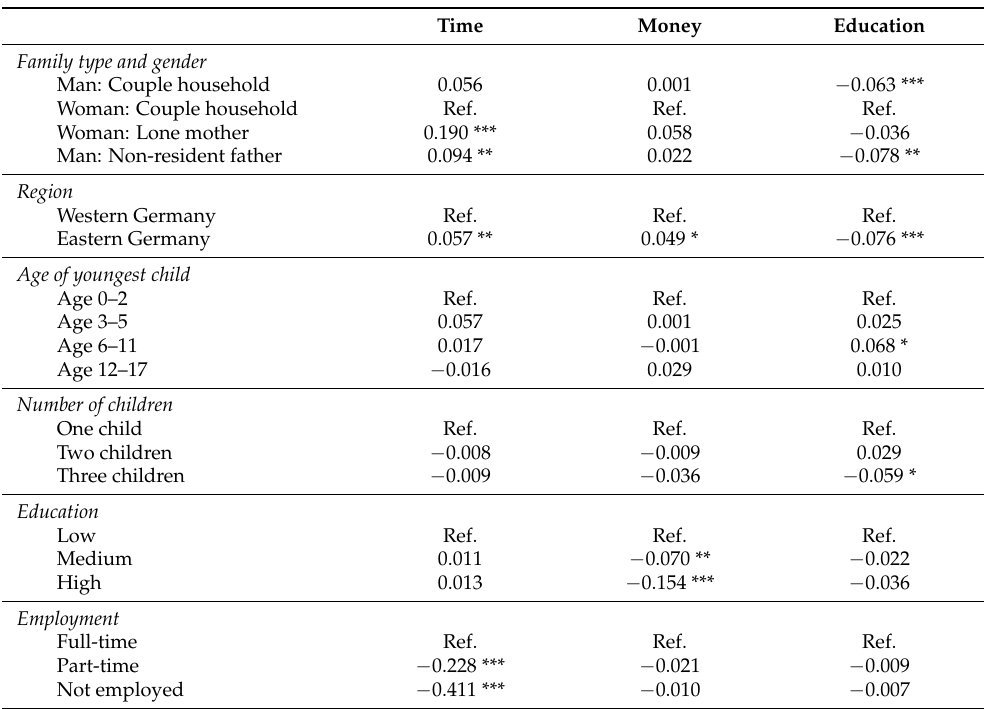
Table 3. Logistic regression model, dependent variable: 1: concerns, 0: no concerns. Average predicted probabilities